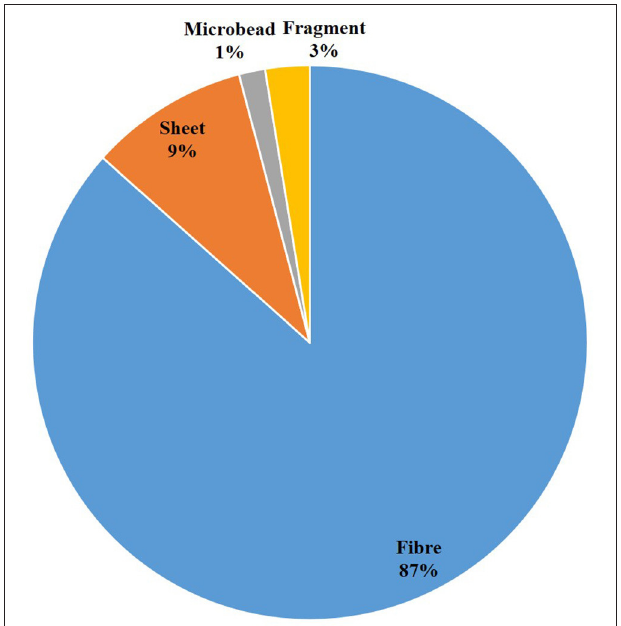
FIGURE 2 | The percentage of microplastic types observed in core samples A and